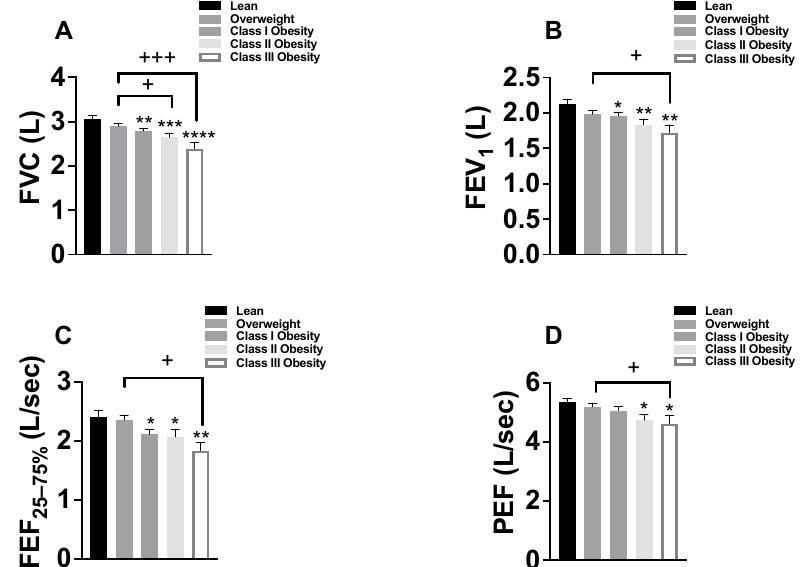
Figure 3. Effect of overweight and obesity on spirometry values in patients with asthma. Patients were divided into four groups based on body mass index (BMI) to assess the impact of overweight and obesity on spirometry values: forced vital capacity (FVC) L ( A ), forced expiratory volume in one second (FEV 1 ) L ( B ), forced expiratory flow at 25% and 75% of the pulmonary volume (FEF 25–75% ) L/s ( C ) and peak expiratory flow (PEF) L/s ( D ). Patients with BMIs ≥ 18.5 to 24.9 kg/m 2 and BMIs of ≥ 25 to 29.9 kg/m 2 were classified as lean ( n = 157) and overweight ( n = 213), respectively. Obesity was subsequently classified into three different groups: class I (BMI of ≥ 30 to 34.9 kg/m 2 , n = 179), class II (BMI of ≥ 35 to 39.9 kg/m 2 , n = 82) and class III (BMI of ≥ 40 kg/m 2 or greater, n = 53). Each data point represents mean ± SEM. * p < 0.05, ** p < 0.01, *** p < 0.001, **** p < 0.0001 compared with lean; + p < 0.05, +++ p < 0.001 compared with